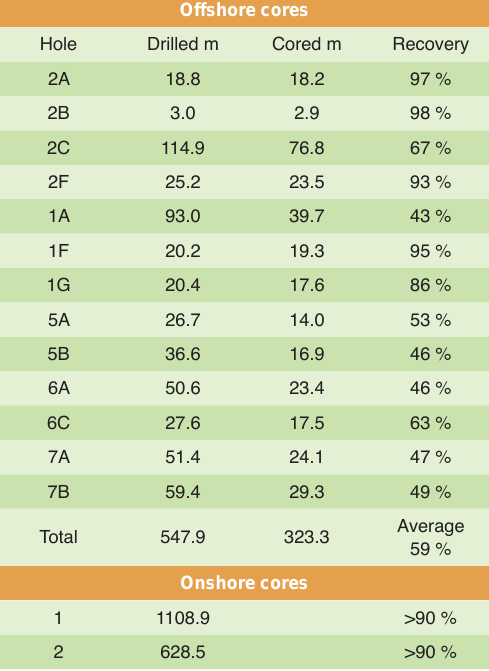
Table 1: Drill holes, core recovery, and statistics of